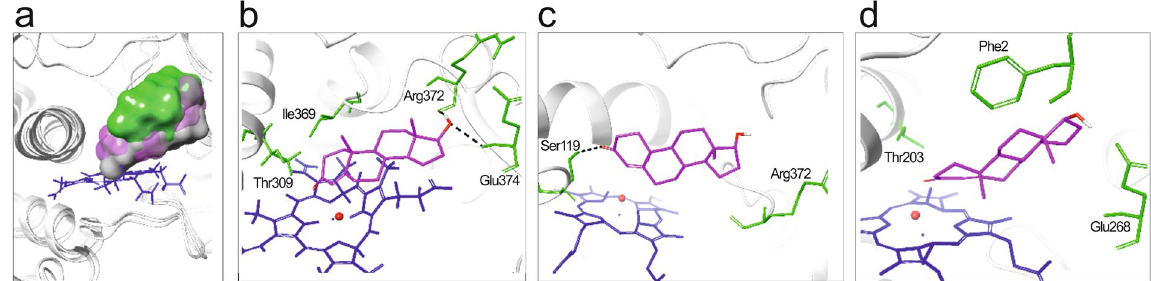
Figure 3. The docking of TST to bCYP3A enzymes. ( a ) The location of the substrate pocket in wild-type CYP3A28 ( grey cloud ), CYP3A38 ( green cloud ) and CYP3A48 ( magenta cloud ) isoforms. ( b–d ) Close-up view of interactions of TST ( magenta ) in the substrate pockets of ( b ) CYP3A28, ( c ) CYP3A38 and ( d ) CYP3A48. Only the most important pocket residues ( green ) are shown for clarity. Black dashes indicate hydrogen bonding, heme is in blue and CYP backbone in grey ribbon.